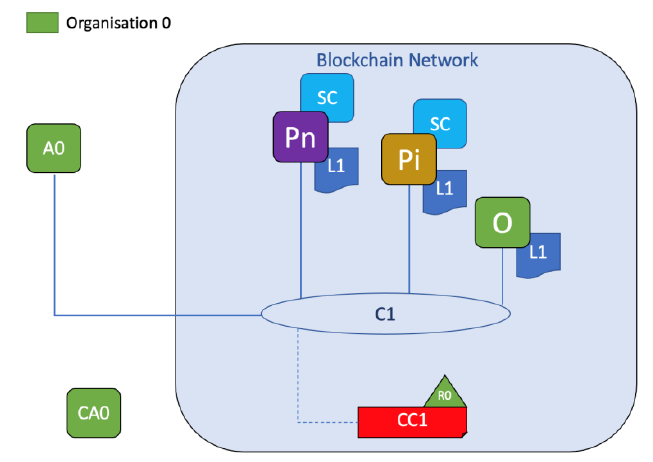
Figure 6: Blockchain